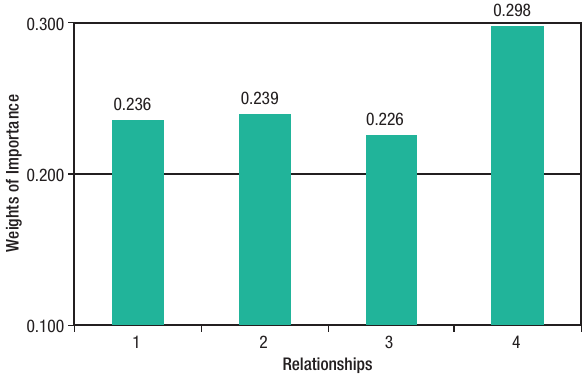
Fig. 1. Utility function values for relationships between key project parties: 1) Project owner